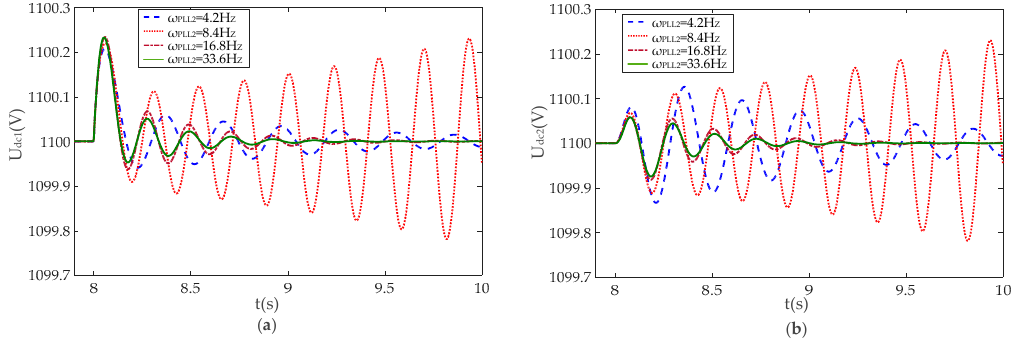
Figure 15. DC ‐ link voltage responses under different VSC2’s PLL bandwidths in ( a ) VSC1, ( b ) VSC2.